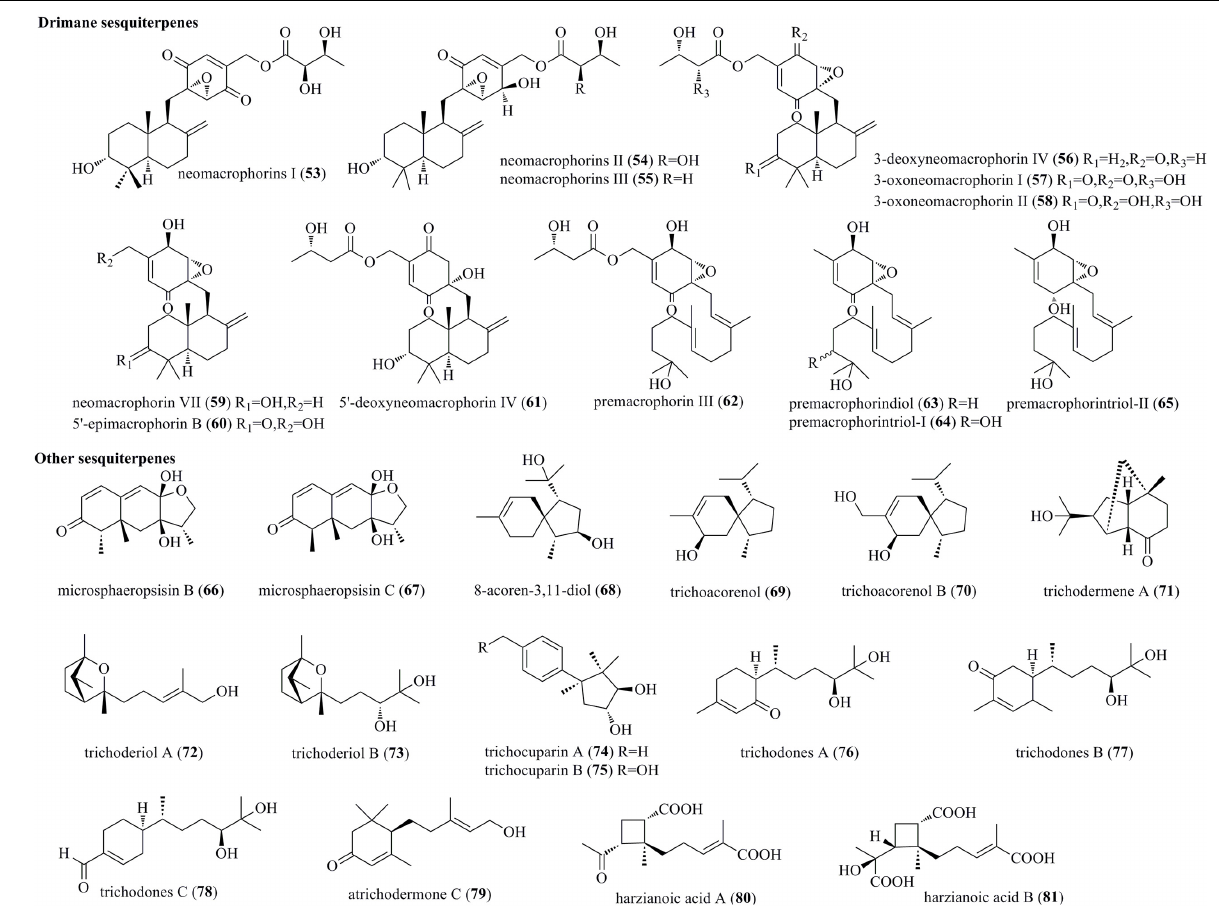
FIGURE 3 | Drimane and other sesquiterpenes produced by Trichoderma species ( 53–81